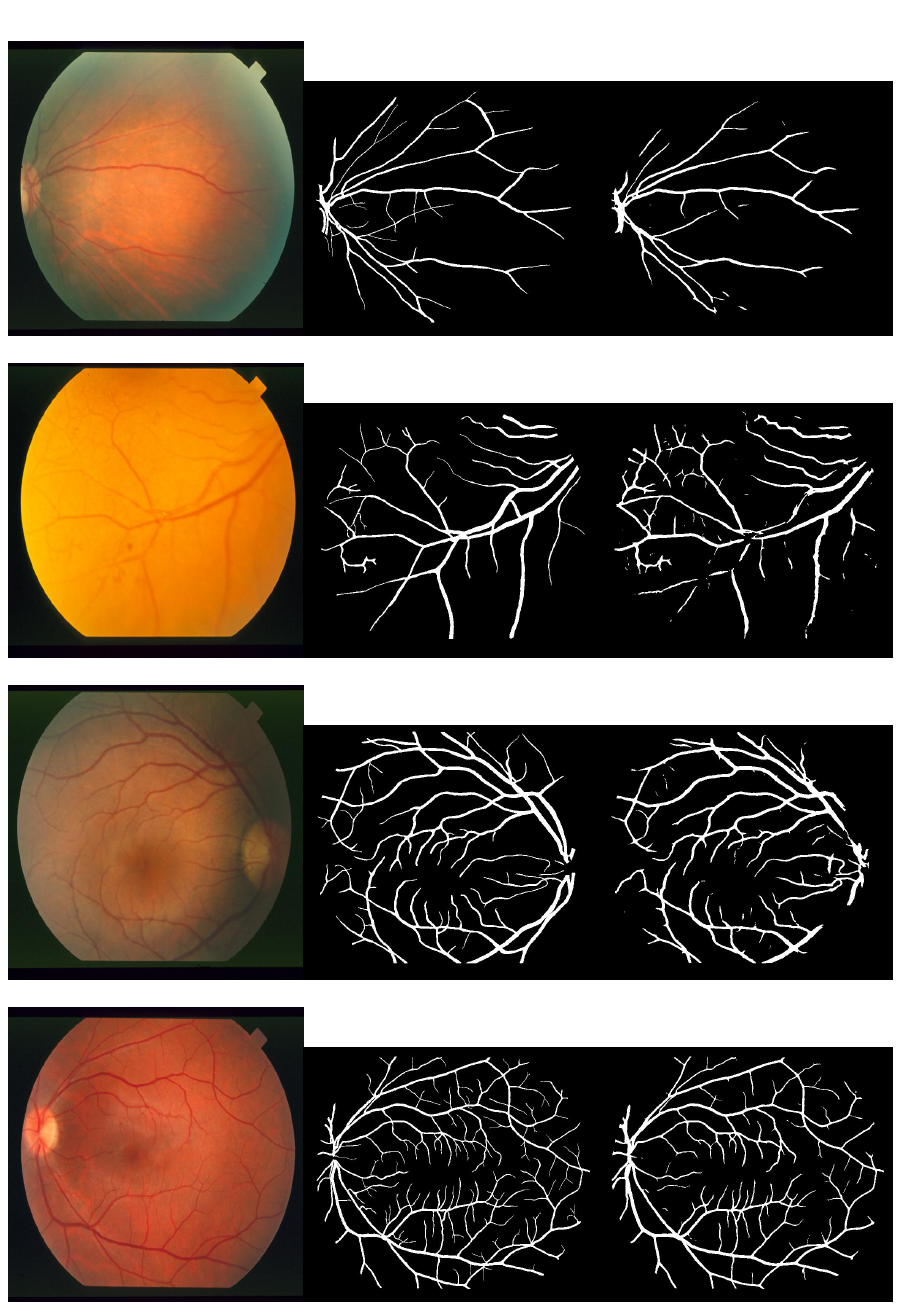
Figure 4. Sample images, their corresponding ground truth and the outcome of the proposed network while testing the STARE dataset (left to